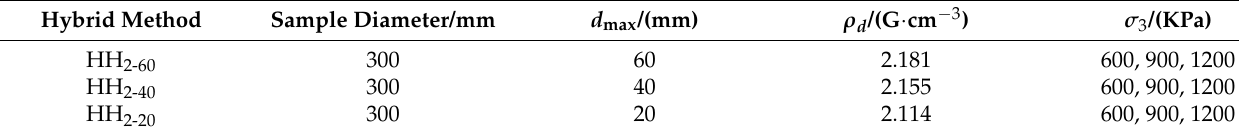
Table 2. The test plan.